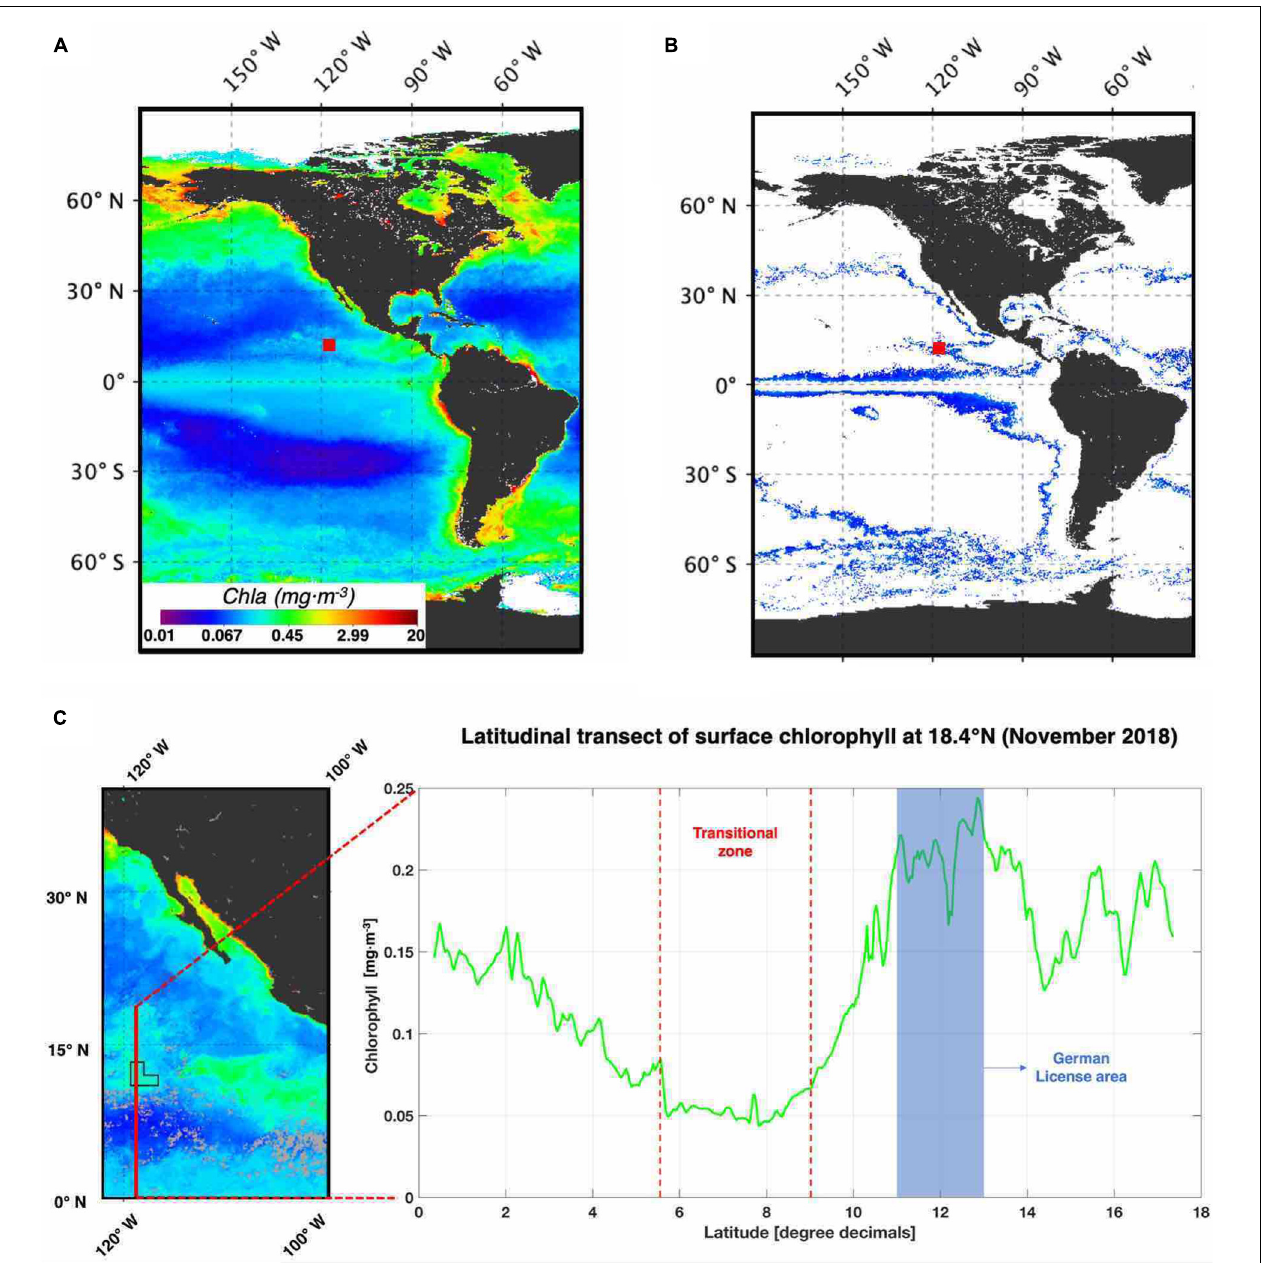
FIGURE 9 | Worldwide 2018 chlorophyll-a distribution pattern. (A) 2018 annual Chla (mg · m − 3 ) global distribution from SeaWiFS. The German license area is indicated by a red square. (B) Colored area showing distribution patterns where the annual Chla concentration is equal to the German license area. (C) Latitudinal transect of surface Chla at 18.4 ◦ N from November 2018 showing the transitional zone between the equator toward the German license